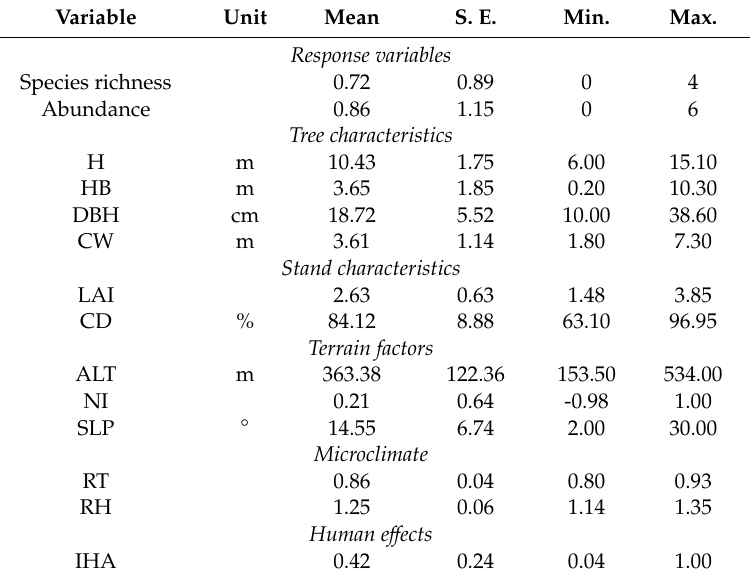
Table 1. Summary statistics for the